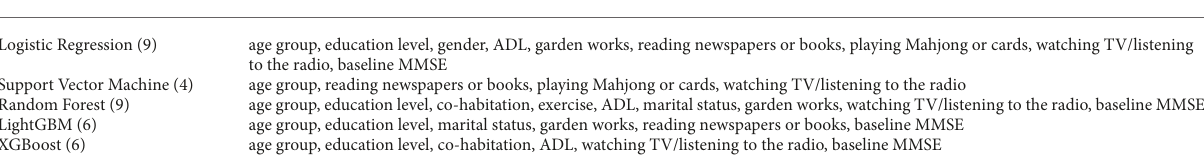
TABLE 2 Selected features by each